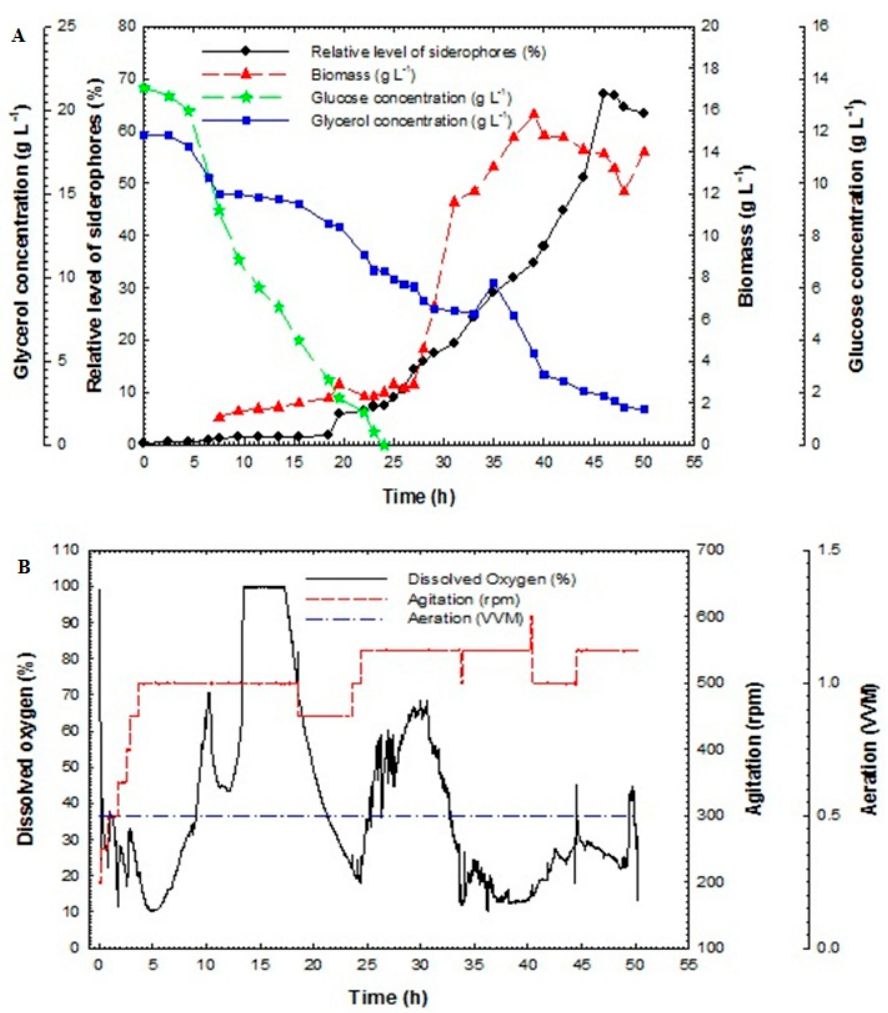
Figure 5. ( A ) Relative level of siderophores, biomass, glucose concentration and glycerol concentration as a function of time for fed-batch fermentation culture broth of Pseudomonas aeruginosa F2 and ( B ) dissolved oxygen, agitation and aeration as a function of time during fed-batch fermentation of Pseudomonas aeruginosa F2.